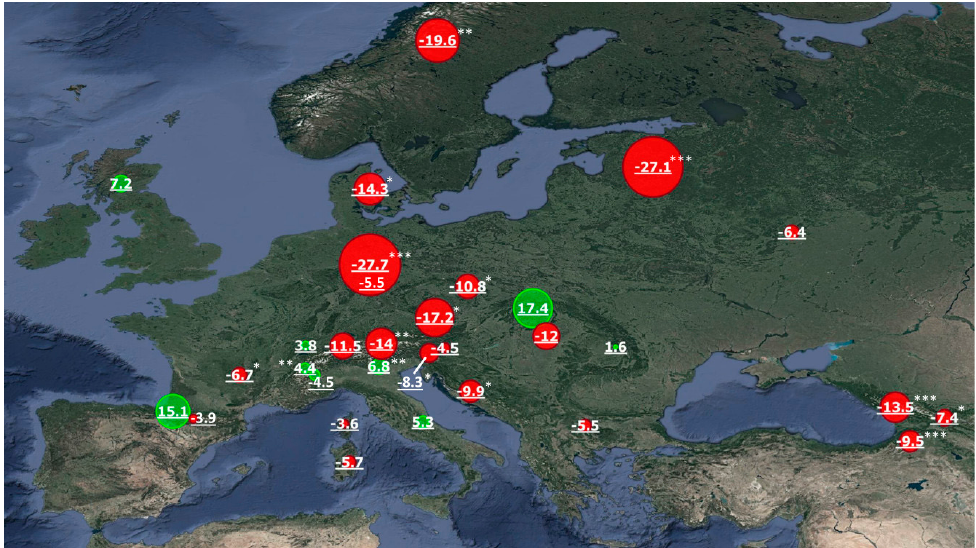
Figure 5. Changes (days) in POS during the period 2001–2021. SOS advance is highlighted with red circles, whereas delay is highlighted with green circles. Sites that display a significant POS-year correlation are marked with * (0.05 < F ≤ 0.1), ** (0.01 < F ≤ 0.05) and *** (F ≤ 0.01). Table 5. Results of the statistical analysis conducted on weather data from 2001 to 2021. R years highlights temperature trends over the 2001–2021 period by reporting the values of the correlation coefficients found by correlating the average winter and spring temperatures with the reference years, while R SOS and R POS report the values found by comparing the extracted SOS and POS with the average winter and spring temperatures of the respective years. For each comparison, the level of significance F is reported ( Sign. ). T mean values represent the mean temperatures of the winter and spring seasons, reported to give general information about each site (data not included in the